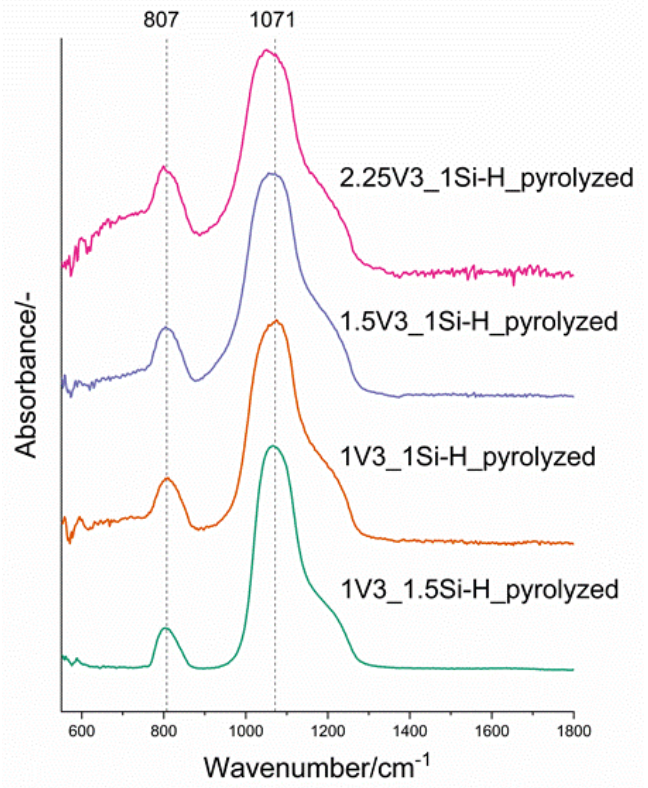
Figure 2. FTIR spectra of the pyrolyzed V 3 polymer-based polyHIPEs.